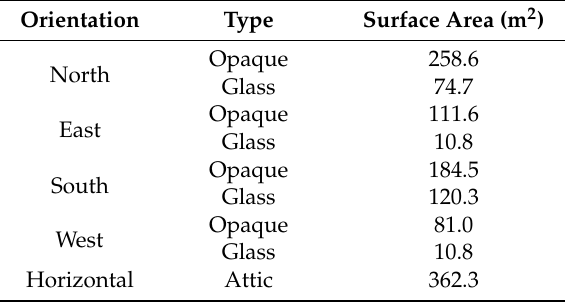
Table 1. Geographical orientation, and the type and area of the boundary surfaces of the air-conditioned rooms of the building.